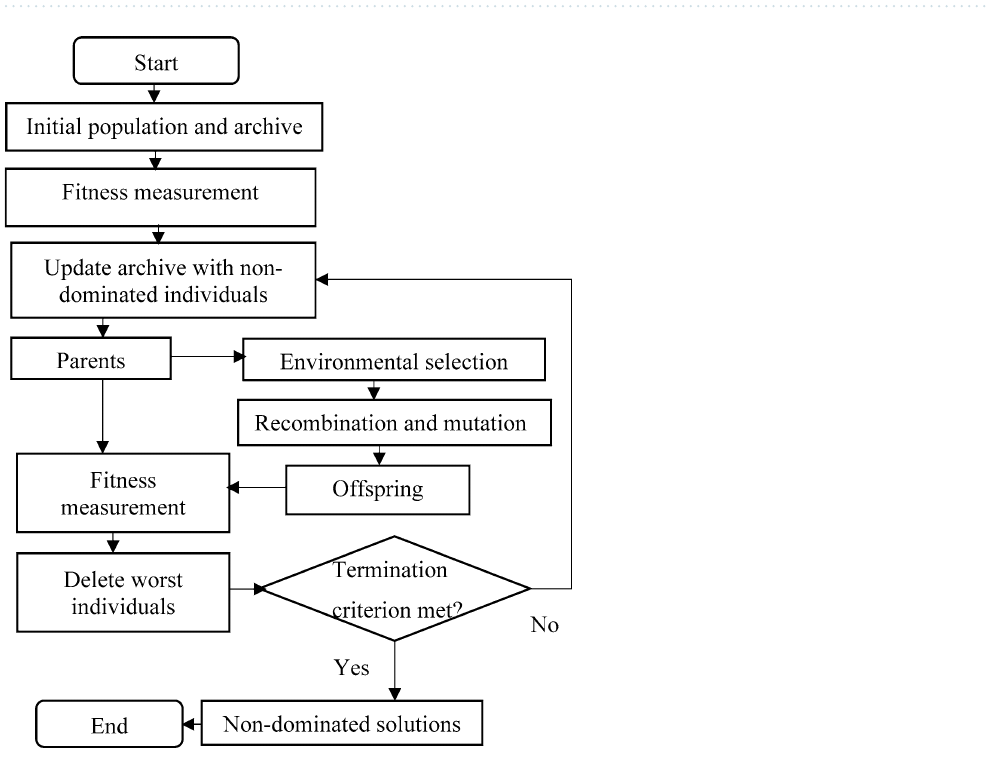
Figure 15. An evaluation procedure of the NSGA-II 55 . Non-dominated sorting divides the population into different ranks (F 0 , F 1 , F 2 , …). Individuals from the same optimal front are maintained in one rank.